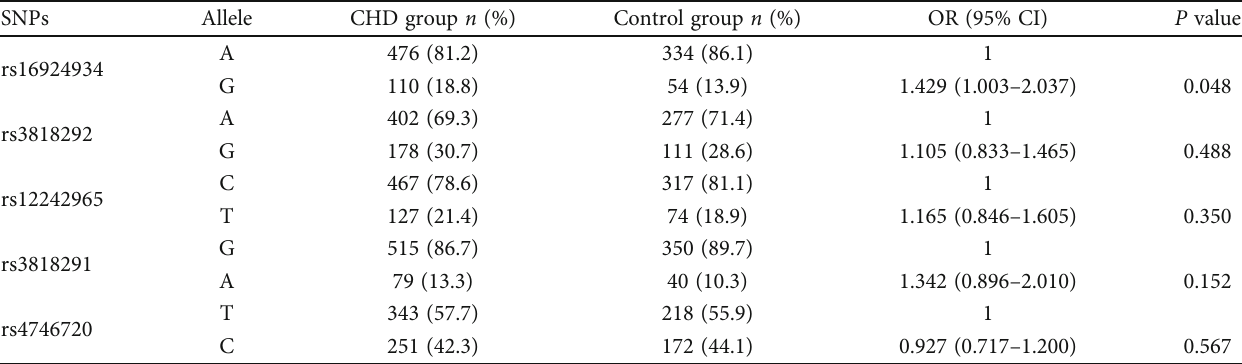
Table 2: Allele distribution of fi ve SIRT1 tag SNPs between the CHD and control groups.